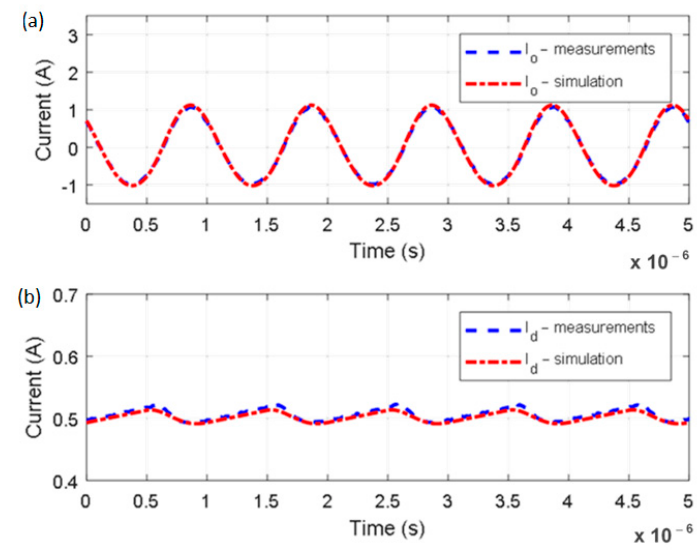
Figure 15. The comparative waveforms of simulation and experimental results: ( a ) output current I o and ( b ) input current I d .